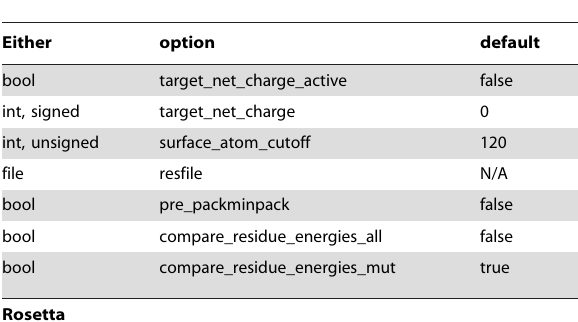
Table 1. Rosetta supercharge options.